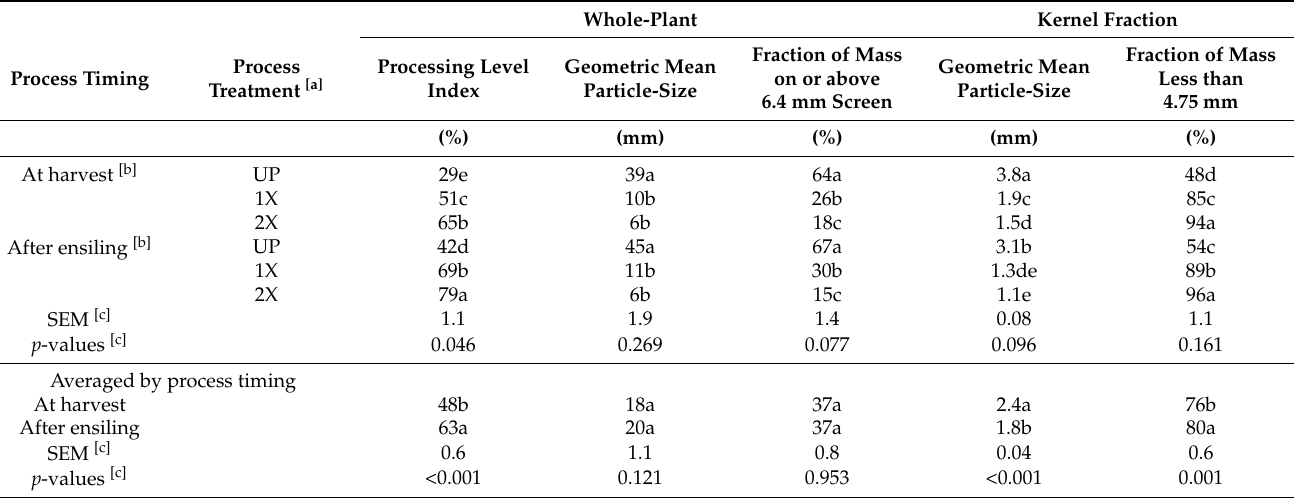
Table 6. Material properties of whole-plant corn processed either at harvest (Experiment 1) or after ensiling.